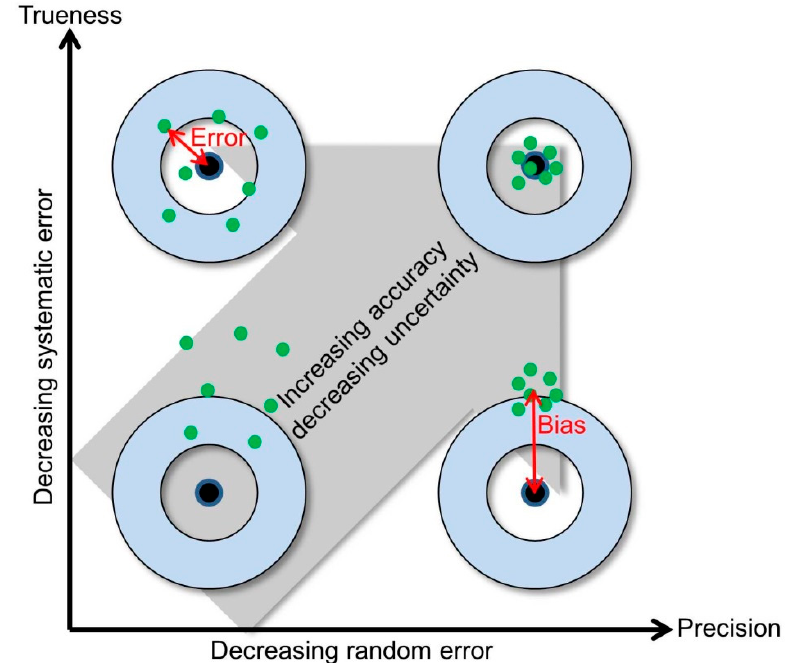
Figure 3. Schematic illustration of validation terms shown for four stages of different measurement mean and variance. Green dots show measurements for every true state (black dots) and its vicinity (blue circles).